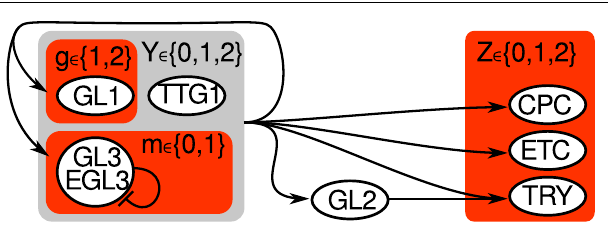
FIGUREA1 | Hybrid sketch of Arabidopsis thaliana ’s leaf epidermis regulation before and after the simplification. All nodes from the original variant (Benítez et al., 2008) are labeled by 3 or 4 letters.The simplified system consists of three nodes g , m , z only, highlighted by red shaded rectangles.The auxillary variable Y (light gray shaded) is not required any more, while Z ∈ {0, 1, 2} is transformed into two Boolean nodes z ∈ {00, 01, 10, 11}.